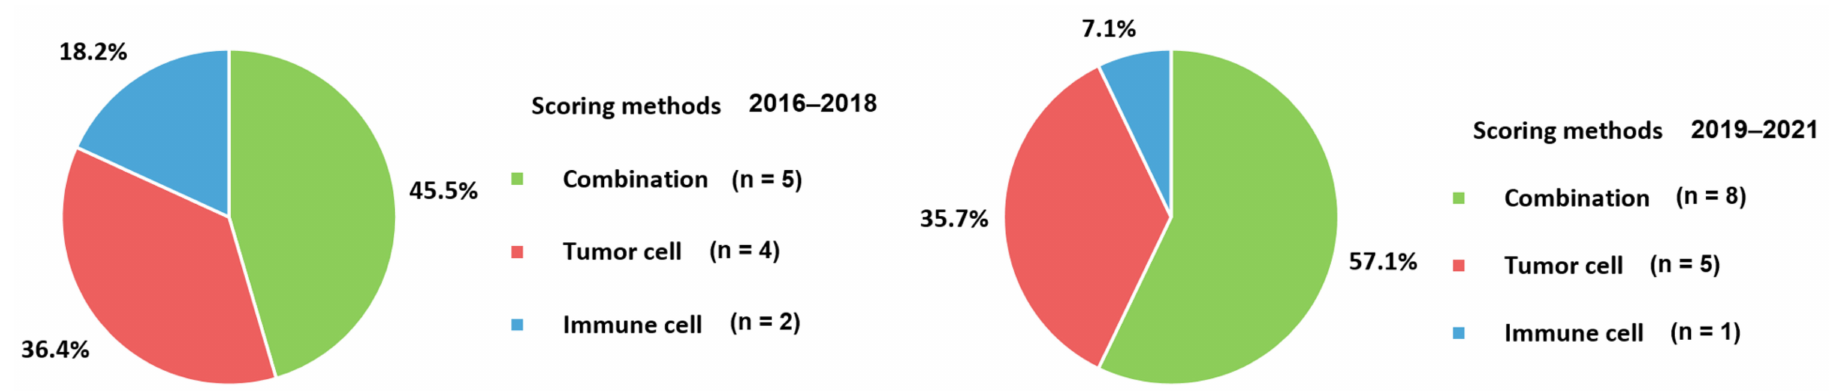
Figure 9. Changes in scoring methods for PD-1 axis. PD-1, programmed cell death